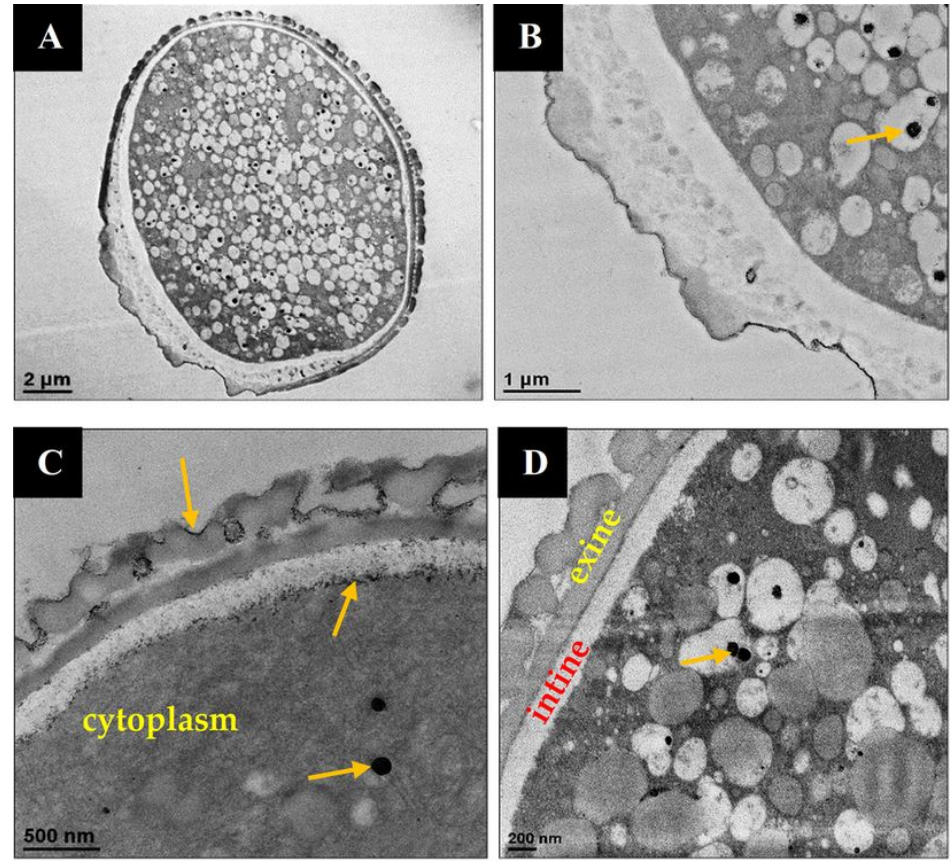
Figure 3. ( A – D ) TEM images of cross-section of a raw swelled DPP pollen showing its microstruc- ture. Arrows indicate accumulation of staining materials on parts of intine and exine layers.